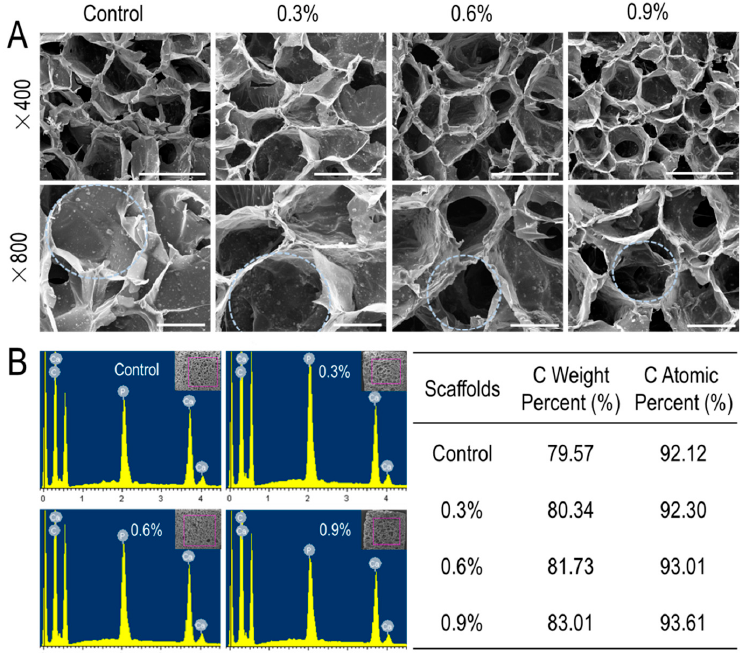
Figure 2. ( A ): SEM observation of CS/Gel/nHAp/MWCNTs scaffolds. ×400 scale: 300 μ m; ×800 scale: 100 μ m; the circle marks the pores in the scaffold and highlights that the diameter of the scaffold decreased slightly with increasing MWCNTs content. ( B ): Semi-quantitative analysis of CS/Gel/nHAp/MWCNTs scaffolds. Regions of each scaffold were selected for EDS semi-quantitative elemental analysis; the result demonstrates that both the C weight percent and C atomic percent increased with increasing MWCNTs content, and also confirms that MWCNTs were successfully doped into the scaffolds.